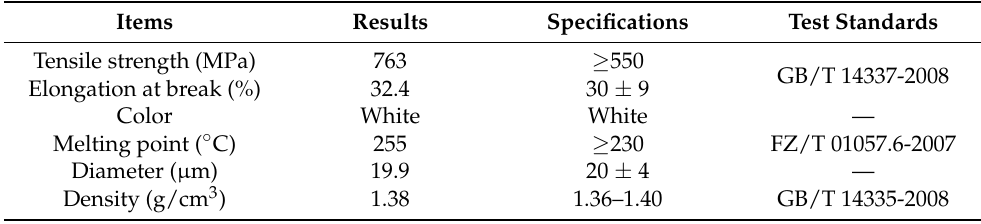
Table 2. Physical properties of polyester